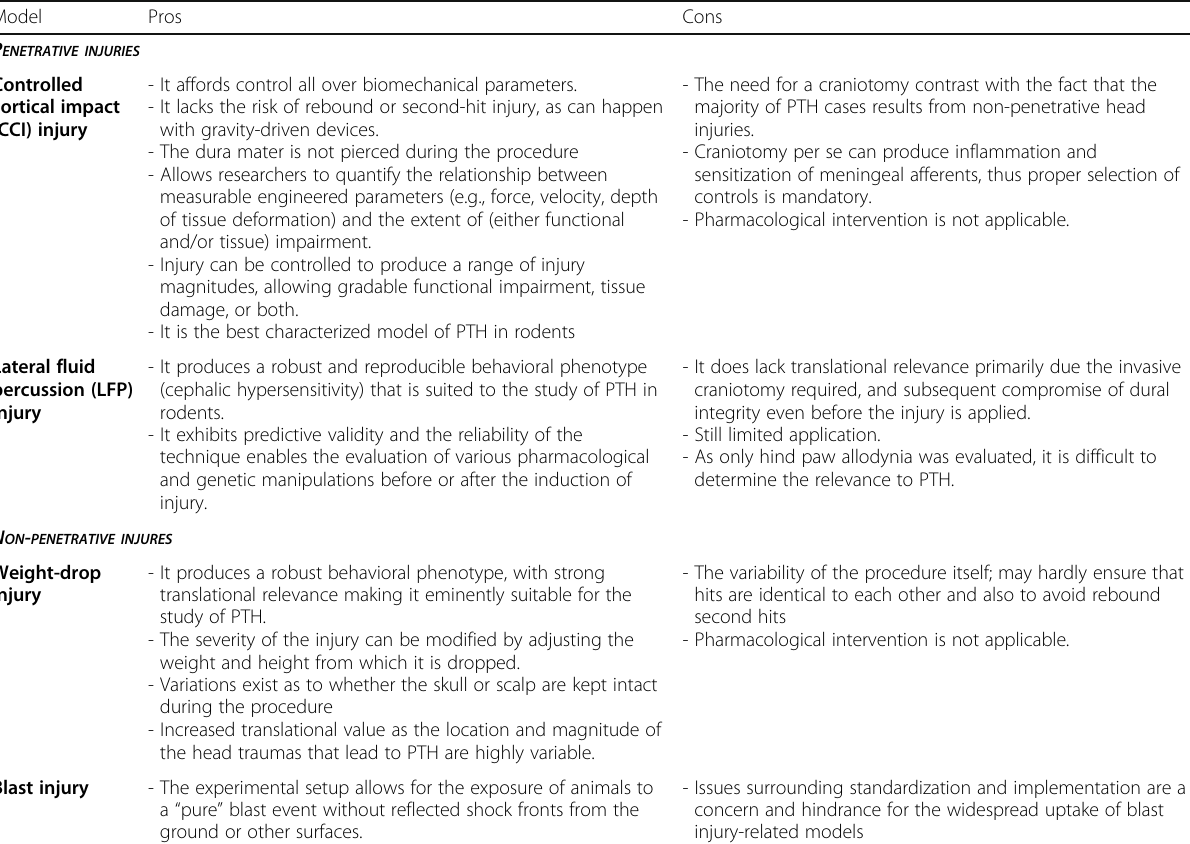
Table 1 Model specific pros and cons of experimental models